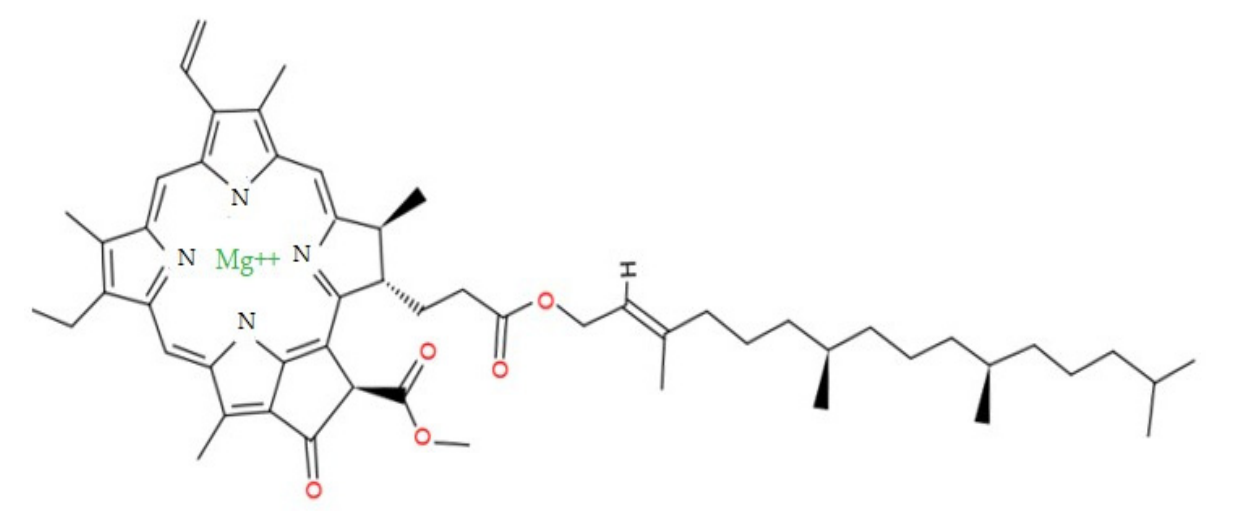
Figure 2. Chemical structure of chlorophyll (PubChem).